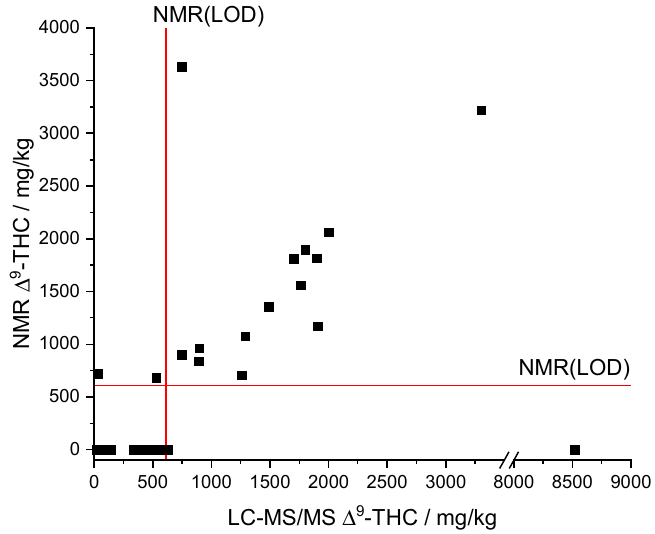
Figure 7. Comparison of NMR and LC-MS/MS results of the measured CBD oil samples. LOD(NMR), limit of detection of qNMR method; ∆ 9 -THC, ∆ 9 -tetrahydrocannabinol.